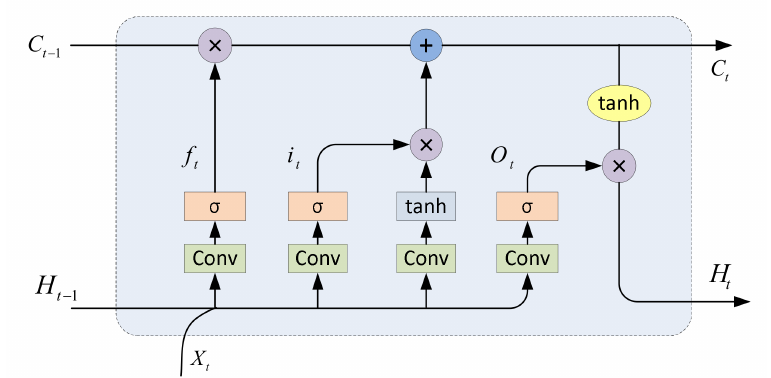
Figure 7. The structure of ConvLSTM. The new memory C t and output H t will be generated by updating the internal memory C t − 1 according to the current input X t and the previous output H t − 1 .